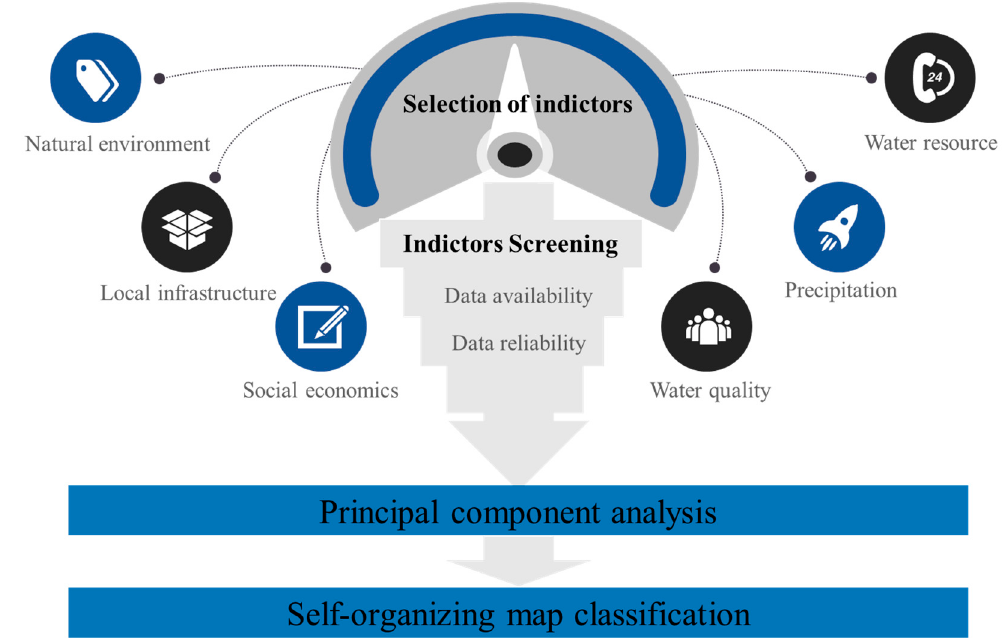
Figure 1. Proposed sponge city management framework.